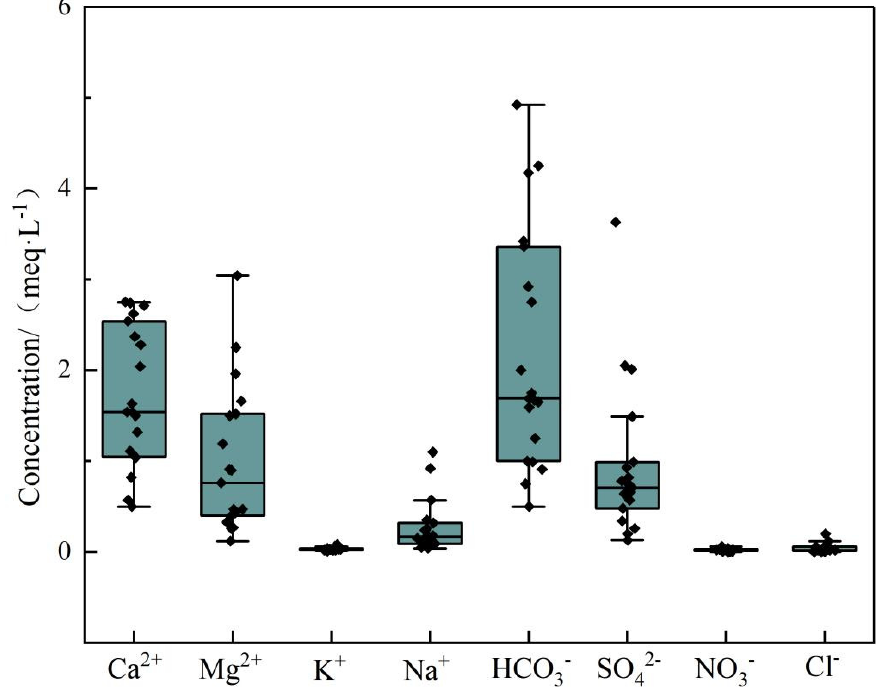
Figure 2. Box-plot of natural water chemical parameters.